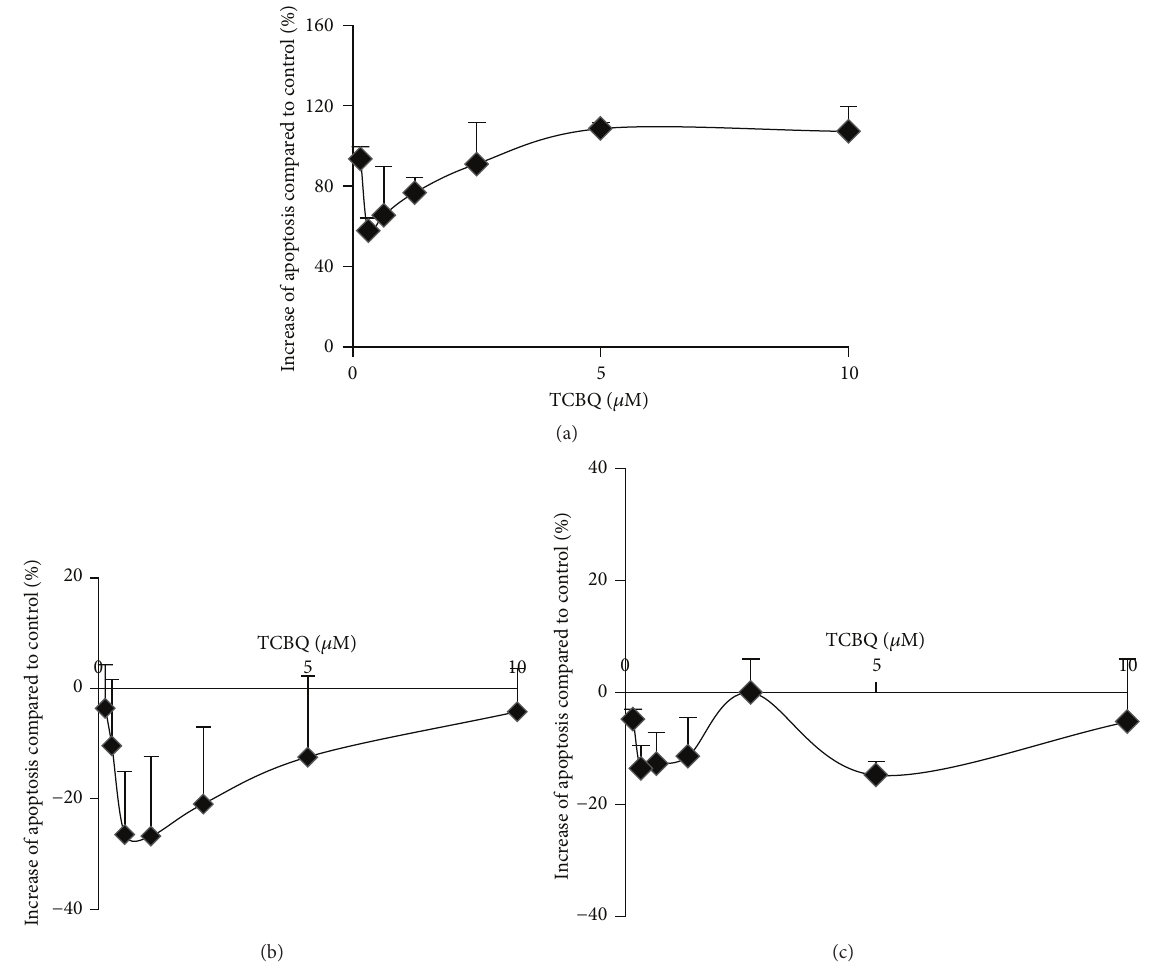
Figure 3: Apoptotic (caspase 3/7 level) effect of TCBQ towards human breast cancer MCF7 (a), Sk-Br-3 (b), and MDA-MB-231 (c) cells. The concentration of TCBQ was 0.16 𝜇 M, 0.31 𝜇 M, 0.63 𝜇 M, 1.25 𝜇 M, 2.5 𝜇 M, 5 𝜇 M, and 10 𝜇 M, respectively. Treatment with DMSO was used as negative control. Apoptosis was increased upon TCBQ treatment towards the MCF7 cells. The increase of apoptosis (%) compared to control was statistically significant at all TCBQ concentrations. However, apoptosis was decreased upon TCBQ treatment against the Sk-Br-3 and MDA-MB-231 cells. The decrease of apoptosis (%) compared to control was statistically insignificant at all TCBQ concentrations towards both cell lines. Statistical analysis was performed by one-way ANOVA with Dunnett’s comparison as posthoc analysis.